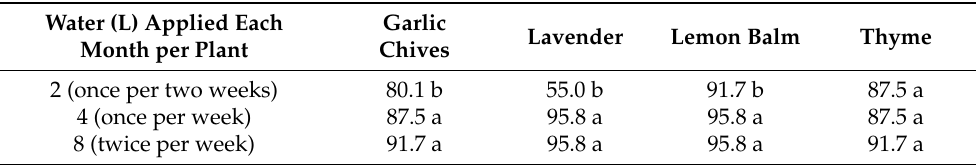
Table 2. Perennial herb winter survival percentage as influenced by irrigation application timing and species in an extensive green roof environment, combined over the 2018 and 2019 growing seasons. Water (L) Applied Each Garlic Month per Plant Chives 2 (once per two weeks)